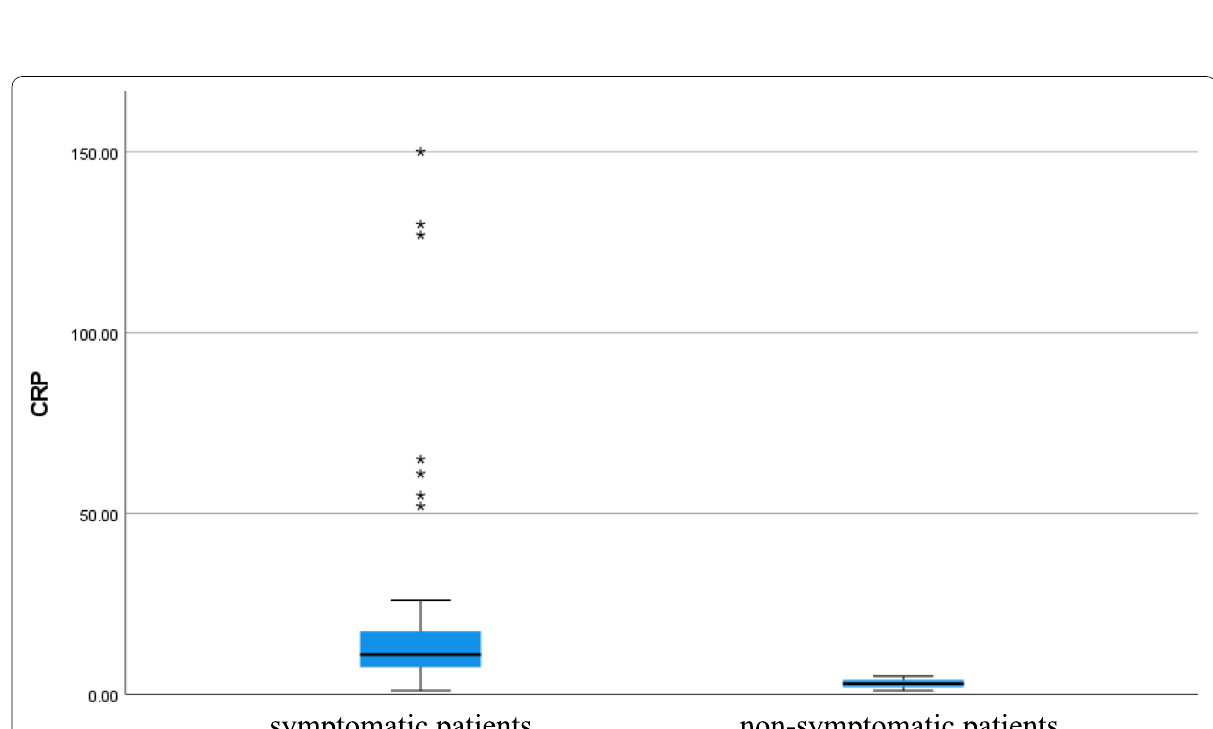
Fig. 6 C-Reactive protein level of COVID 19 patients (symptomatic and